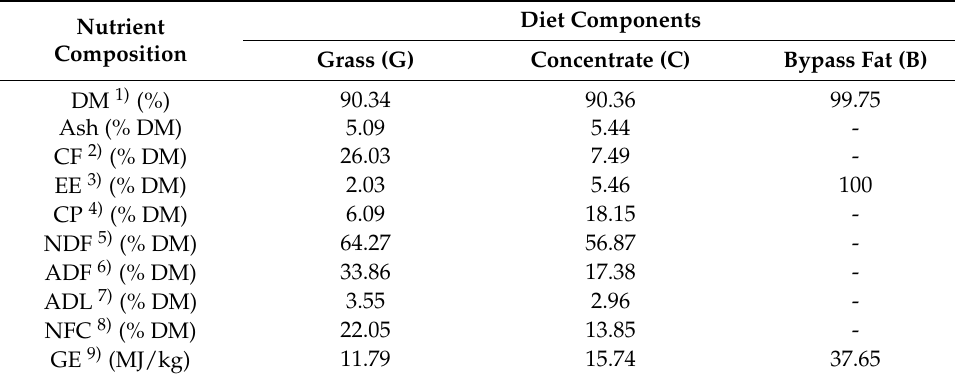
Table 1. Nutritional composition of feedstuff (% DM